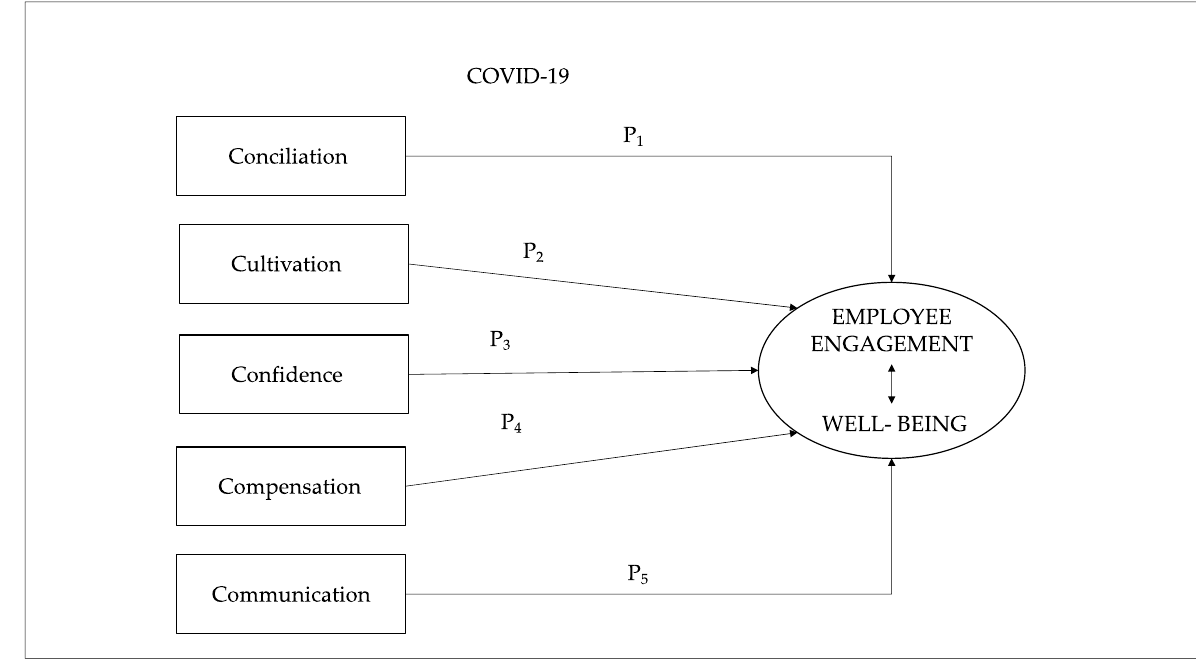
Figure 1. Structural representation of 5C model.